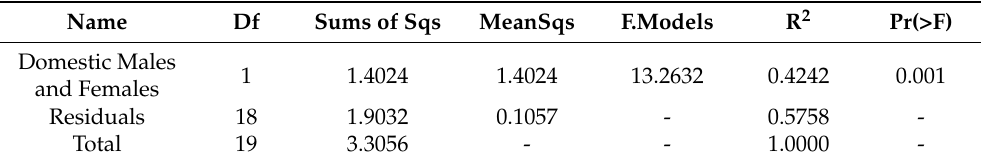
Table A2. Results of the PERMANOVA analysis of the gut microbial diversities between domestic males and females.